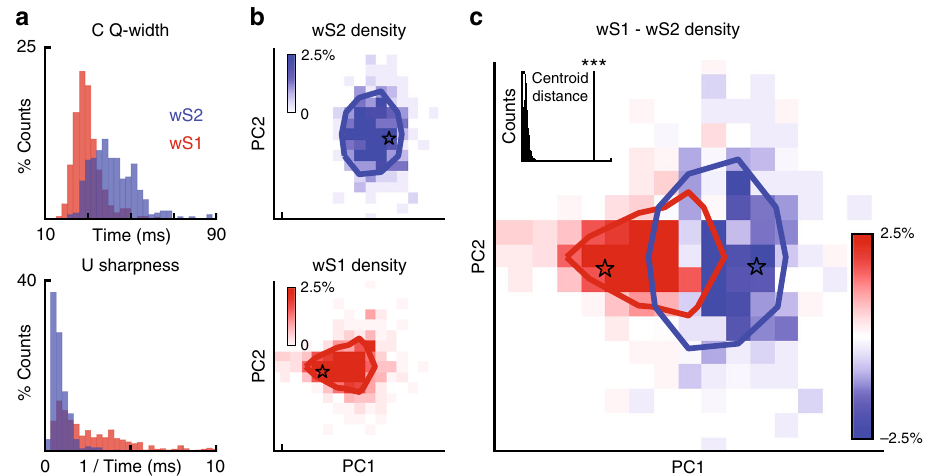
Fig. 5 TPM reveals wS2 and wS1 specialization. a Top: correlated quarter-width feature (Q-width) of PS-STA across all responsive neurons in wS2 and wS1. Bottom: the sharpness (height/width) of the PS-STA to the whisker eliciting the strongest response during uncorrelated stimulation. All quanti fi ed PS-STA features are detailed in Supplementary Fig. 4. b Top: wS2 density plot across the fi rst two principal components of all quanti fi ed PS-STA features. Bottom: wS1 density plot across the fi rst two principal components of all quanti fi ed PS-STA features. Solid lines are contours (blue wS2 and red wS1) with everything inside at greater than ¼ of the maximum density. c wS1 – wS2 density plot (blue for higher wS2 densities and red for higher wS1 densities) in feature space shows specialized zones where there is predominance of neurons from each cortical area. Stars (blue for wS2 cell and red for wS1 cell) show location of the example cells from Figs. 3 and